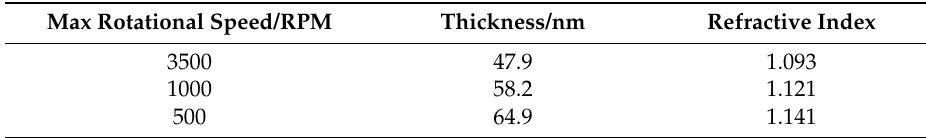
Table 1. The thickness and refractive index as measured by ellipsometry as a function of spin rate in RPM. As the spin rate decreases, the thickness decreases and the refractive index increases.